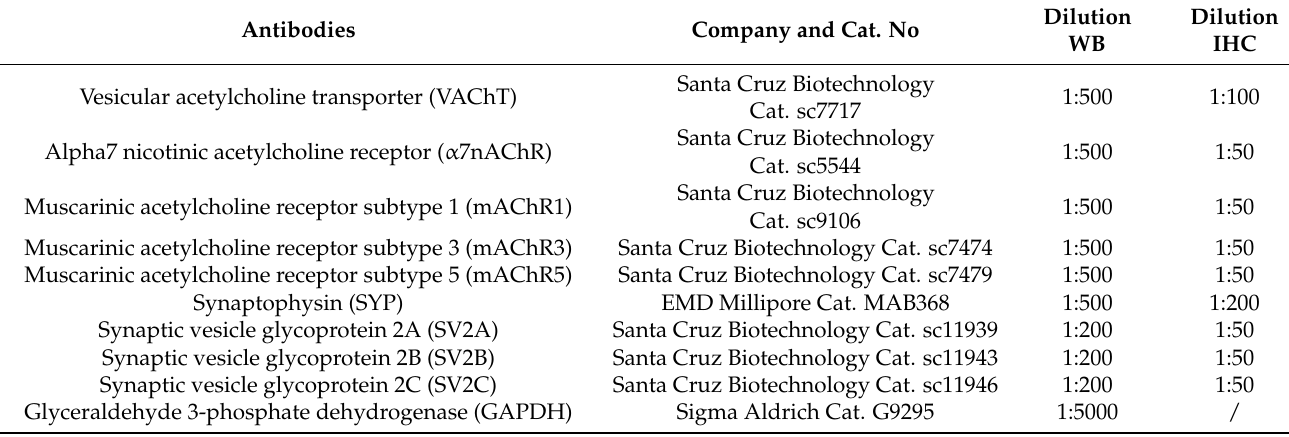
Table 1. Primary antibodies used in Western blot (WB) and immunohistochemistry (IHC).